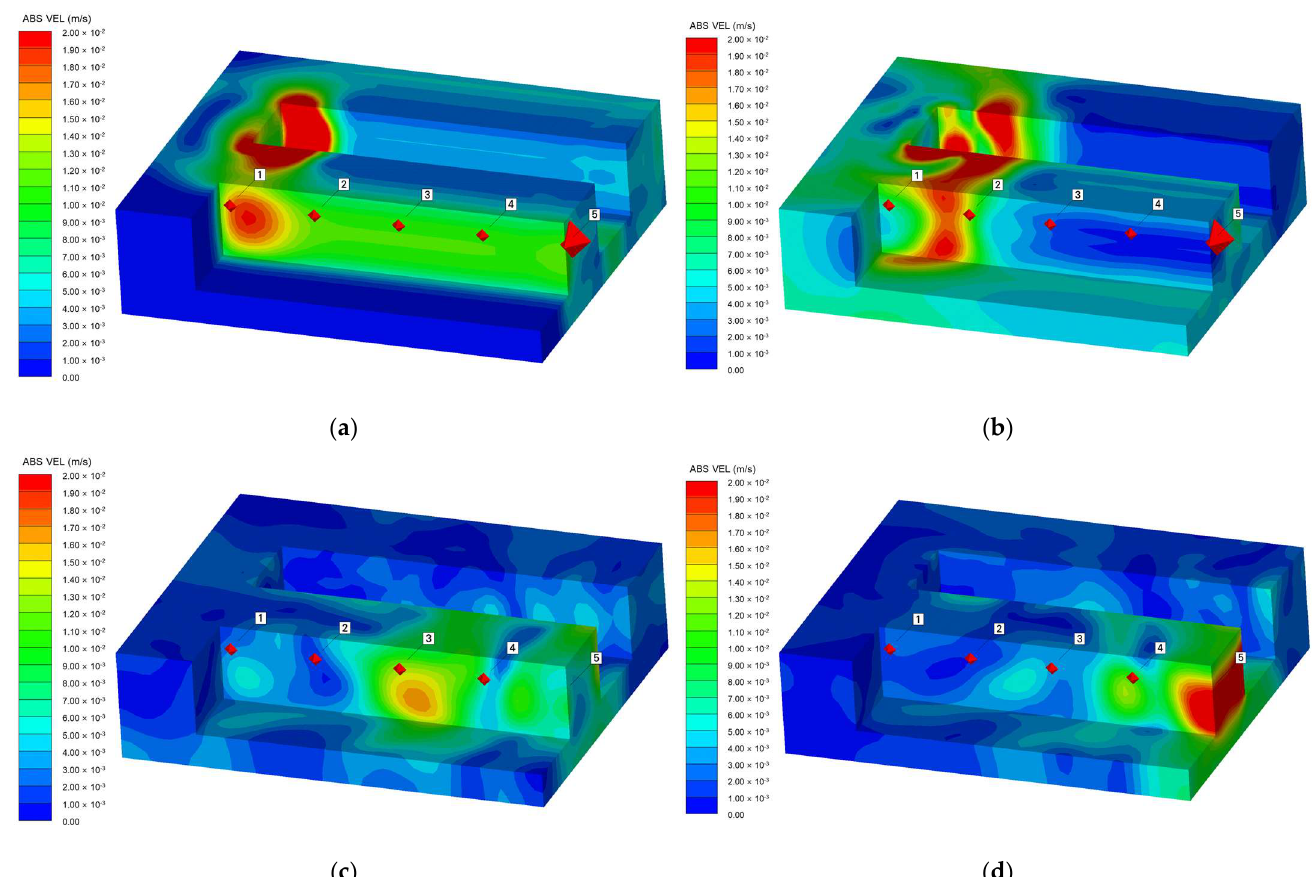
Figure 11. Vibration contours of the rock pillar at each step point after blasting: ( a ) 2 s, ( b ) 5 s, ( c ) 15 s, and ( d ) 20 s.